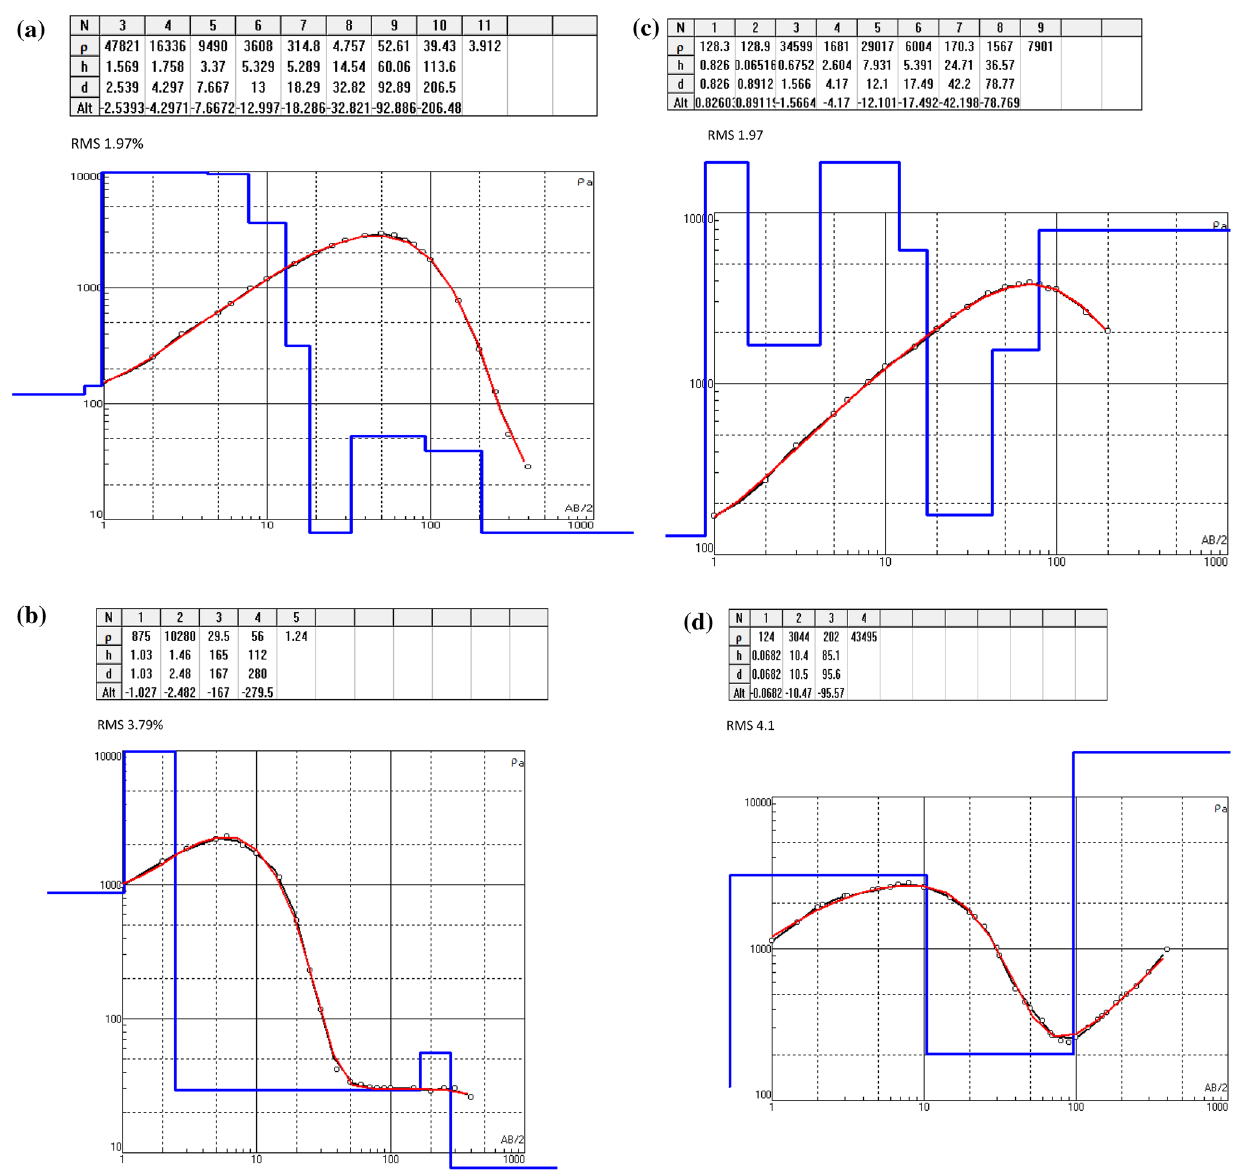
Fig. 4 a Resistivity curve for VES 3 (AK type). b Resistivity curve for VES 1 (KQ type). c Resistivity curve for VES 4 (AAK type). d Resistiv- ity curve for VES 9 (HQH type). e Resistivity curve for VES 2. f Resistivity curve for VES